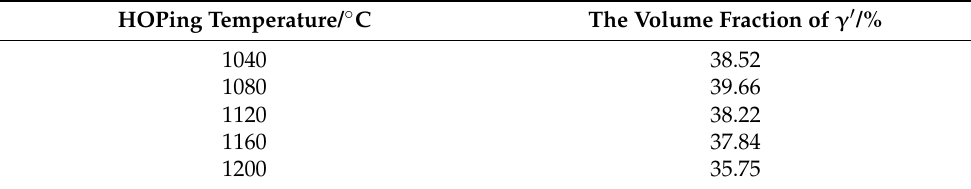
Figure 15. Heating DSC curve of FGH4096 powder. Table 3. The volume fraction of γ (cid:48) phases of the HOP